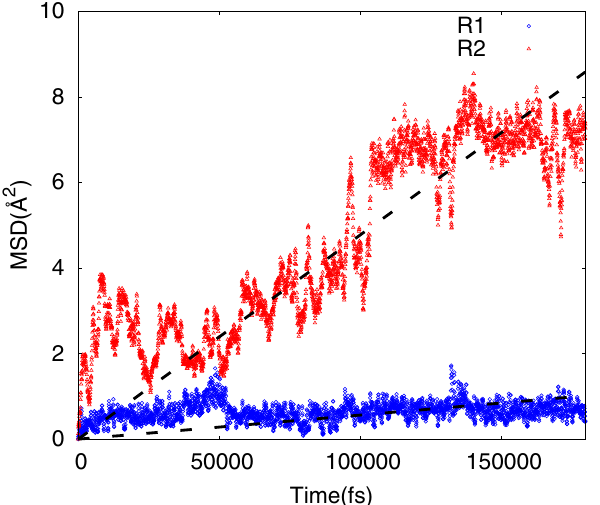
Figure 11. Estimated MSD versus time at T = 300 K for 100 TIP3P water molecules initially placed inside the polymer matrix in a region R1 between z > 0 and z < 1.3 nm (blue circles) and in a region R2 corresponding to z > 2 and < 4 nm (red